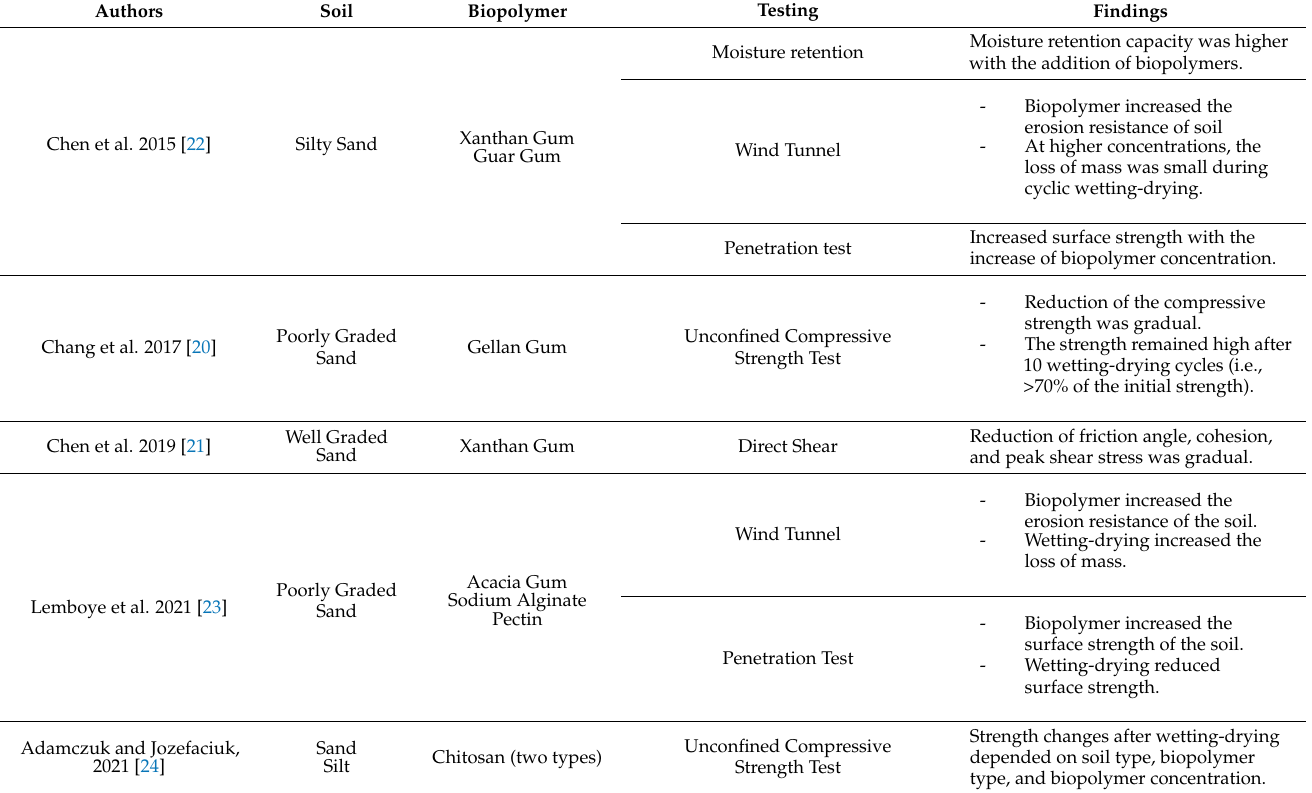
Table 1. Previous research related to wetting-drying of biopolymer-treated